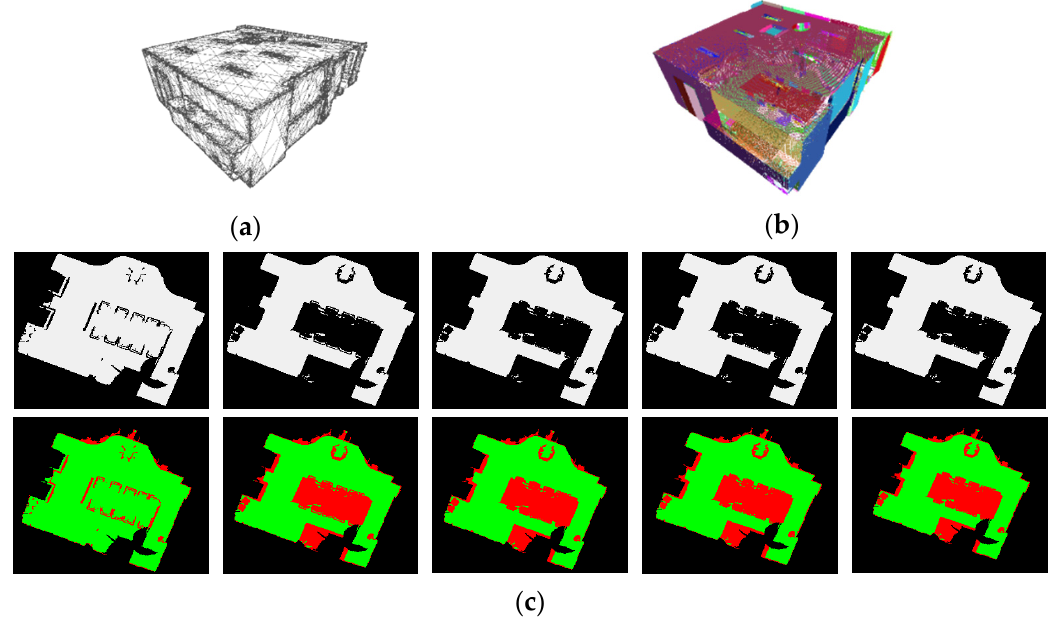
Figure 22. ISE result of real dataset 4: ( a ) FSM result, ( b ) original planar point cloud, and ( c ) PAM.